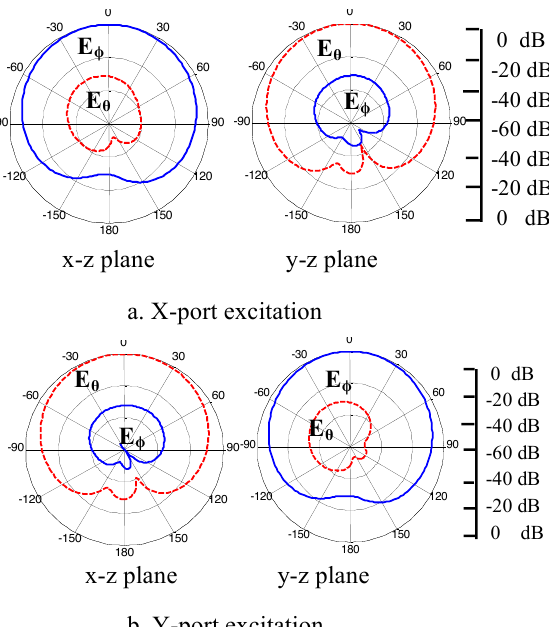
Fig. 7. The surface current distribution on the dual- polarized microstrip patch on-chip antenna for both the X- port and Y-port at 60 GHz.